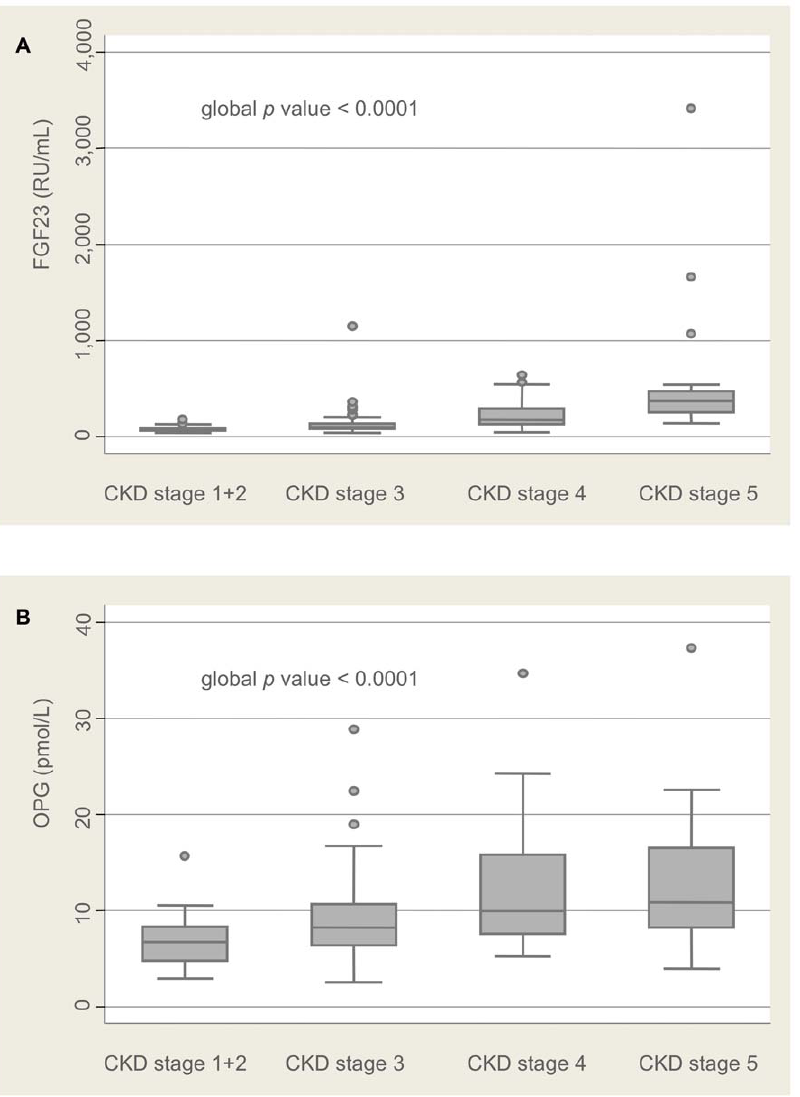
Figure 1. Stratification of bone biomarkers according to CKD stages. FGF23 (A) and OPG (B) median values (quartiles) are depicted according to CKD stages (with a glomerular filtration rate estimated using the reexpressed 4-variable Modification of Diet in Renal Disease (MDRD) 175 study equation).